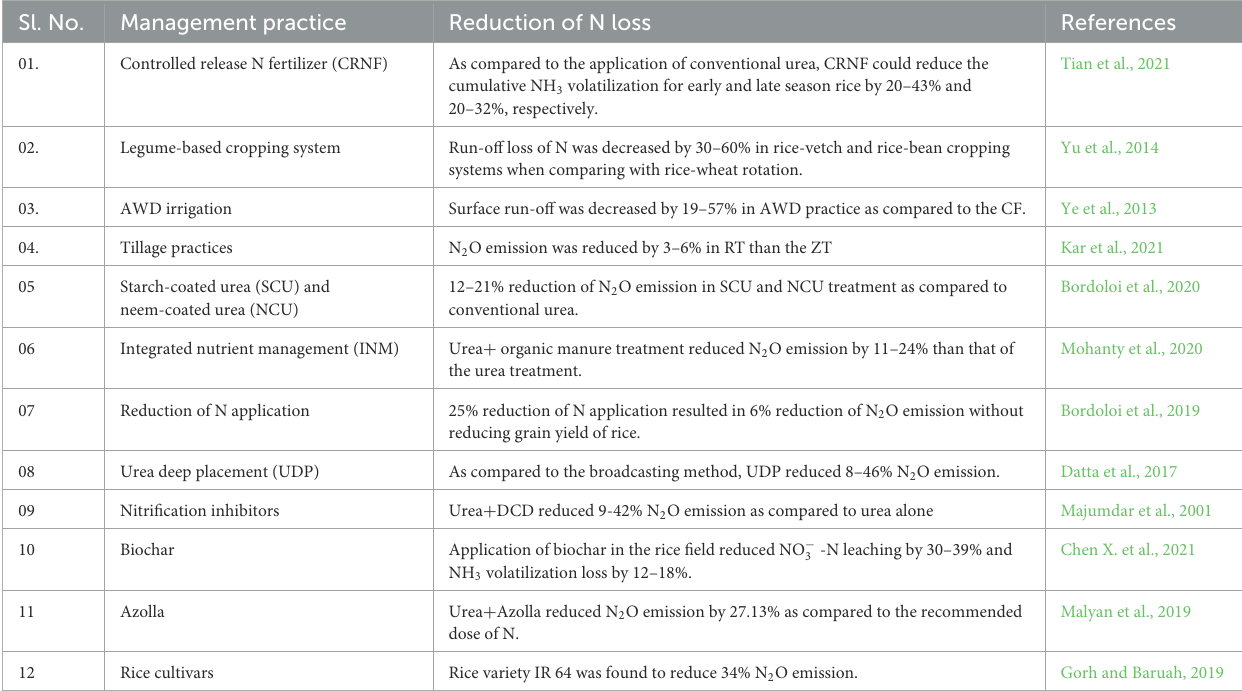
TABLE 4 Reduction of N loss under different management